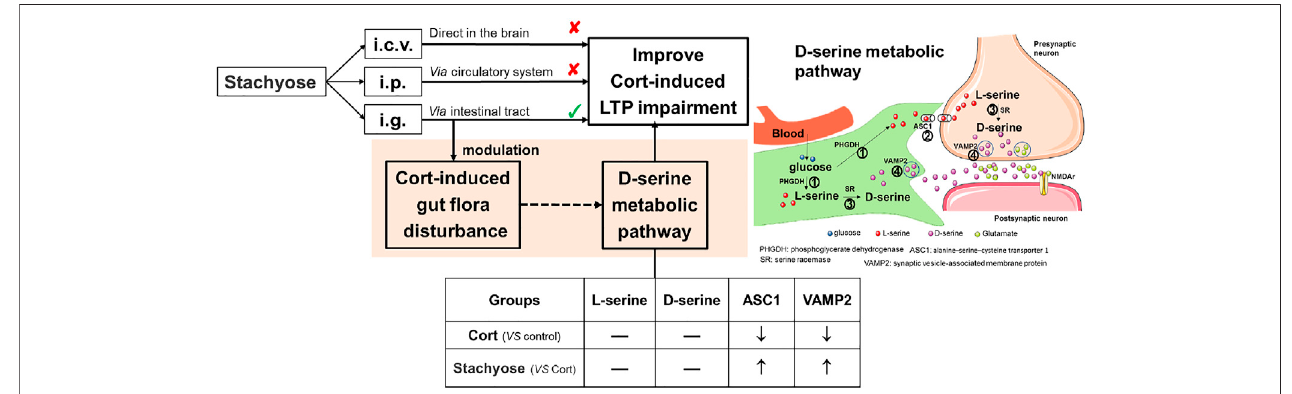
FIGURE 5 | Summary of effects and mechanisms of stachyose. Stachyose can protect LTP impairment against corticosterone via intragastric administration, but there is little effect when administration via intraperitoneal injection or intracerebroventricular injection. Modulating the gut fl ora is involved in the bene fi cial effects of stachyose. Stachyose can restore the D-serine metabolic pathway disturbed by corticosterone.